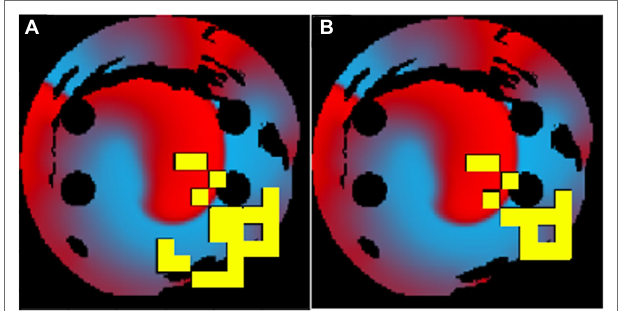
FIGURE 8 | The same patient-specific 2D LA tissue models ablation performed by the agent at (A) 10 ms interval and (B) 50 ms interval. The ablation patterns are similar but not